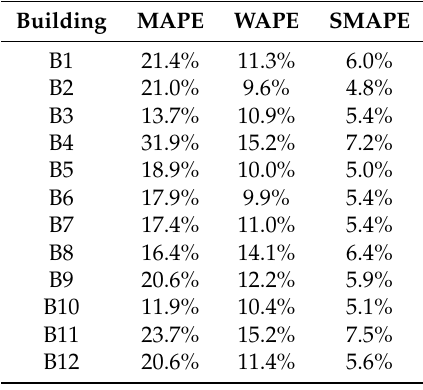
Table 5. Prediction error for each building: artificial neural network model, time frame: 6 a.m–10 p.m.